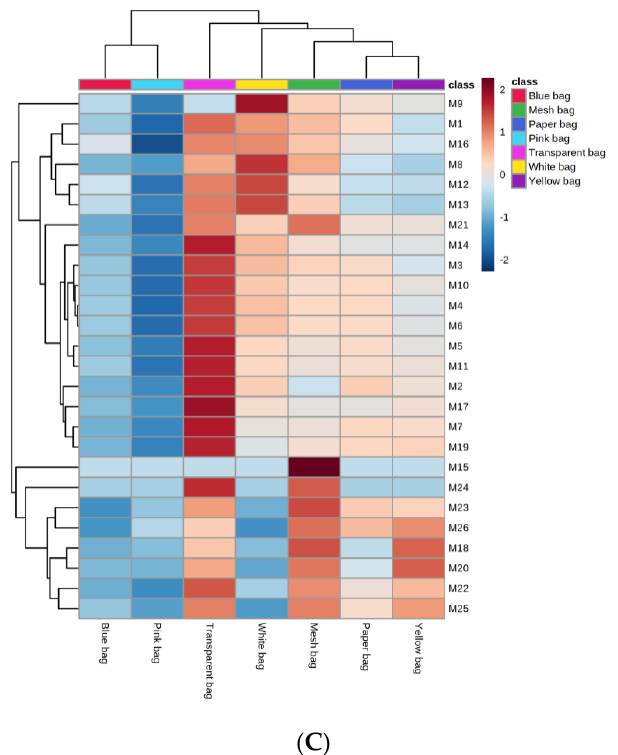
Figure 4. Hierarchical cluster analysis of the effects of fruit bagging treatment with different types of bags on the monoterpene content of three table grape cultivars (( A ): RDZH; ( B ): RDHY; and ( C ): RDHM).